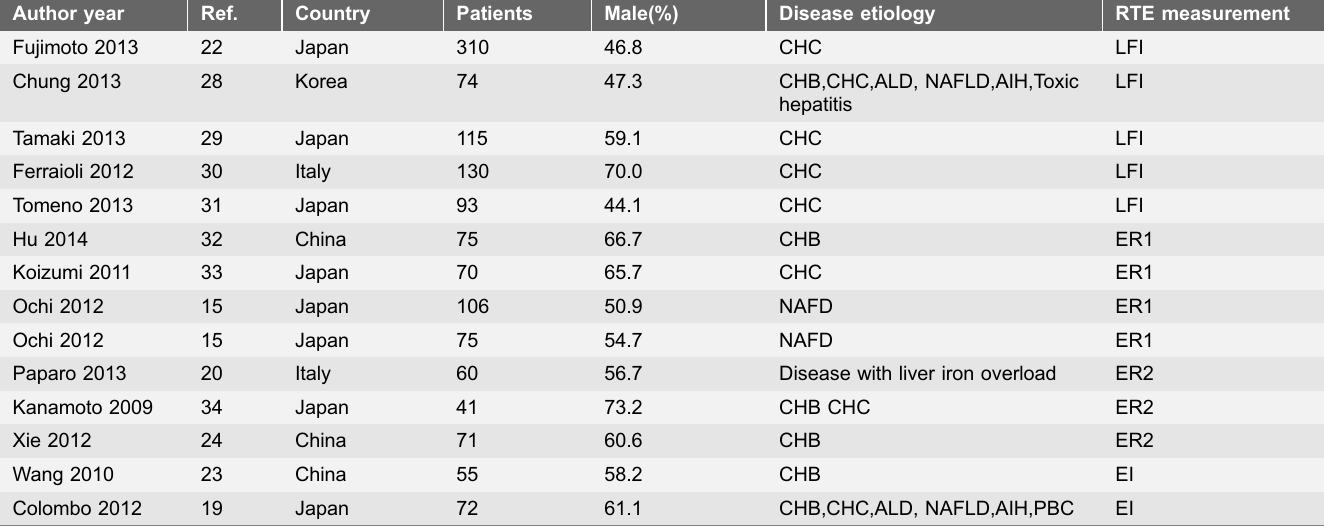
Table 1. Characteristics of studies evaluating the performance of real time elastography for staging liver fibrosis. Author year